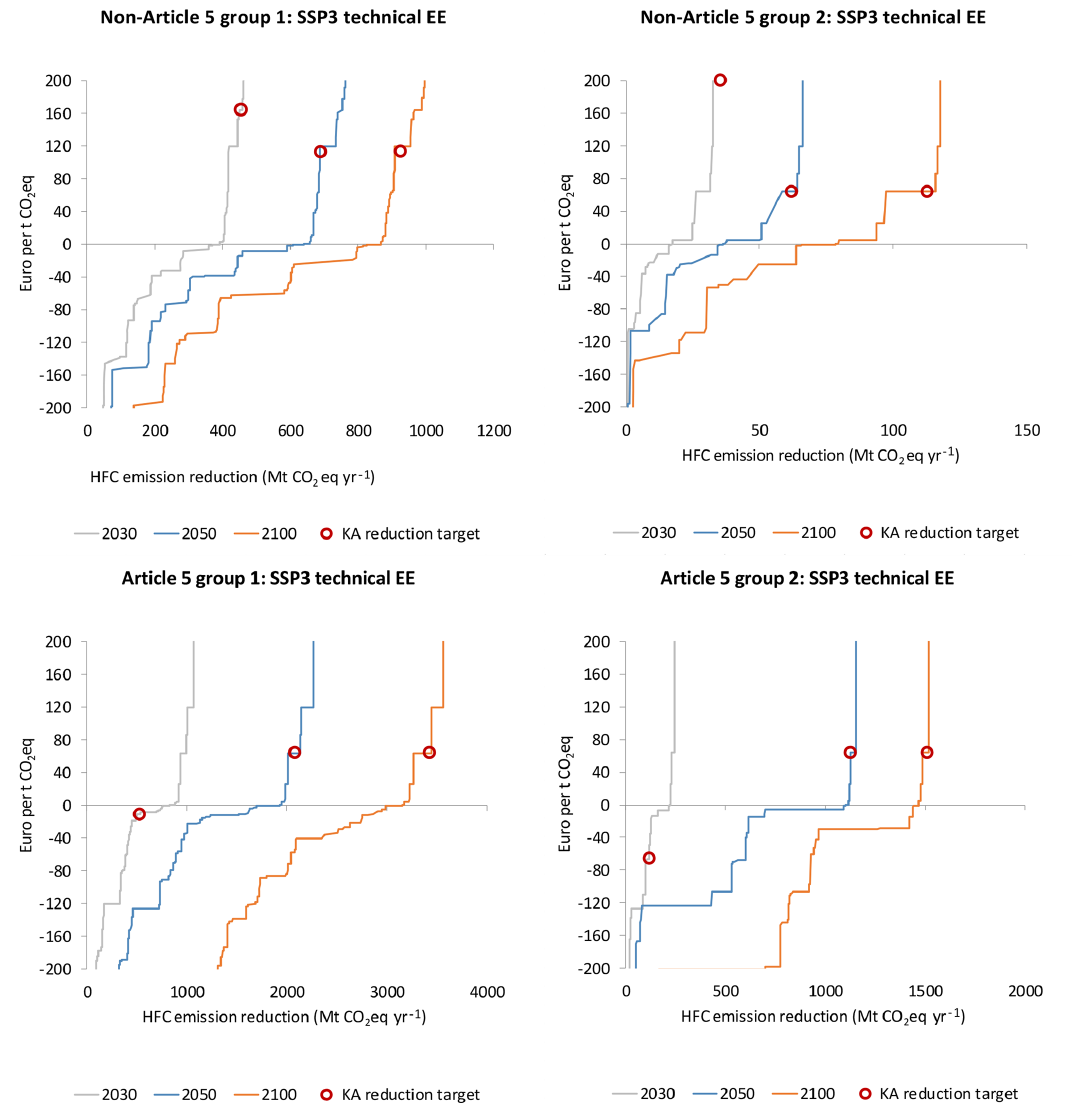
Figure 3. Marginal abatement cost curves (MACCs) starting from a pre-Kigali SSP3 baseline consistent with the IEA-WEO17 New Poli- cies scenario and reducing HFC emissions by Kigali Amendment (KA) party groups under technical energy efficiency improvements and indicating the KA HFC reduction targets in 2030, 2050, and